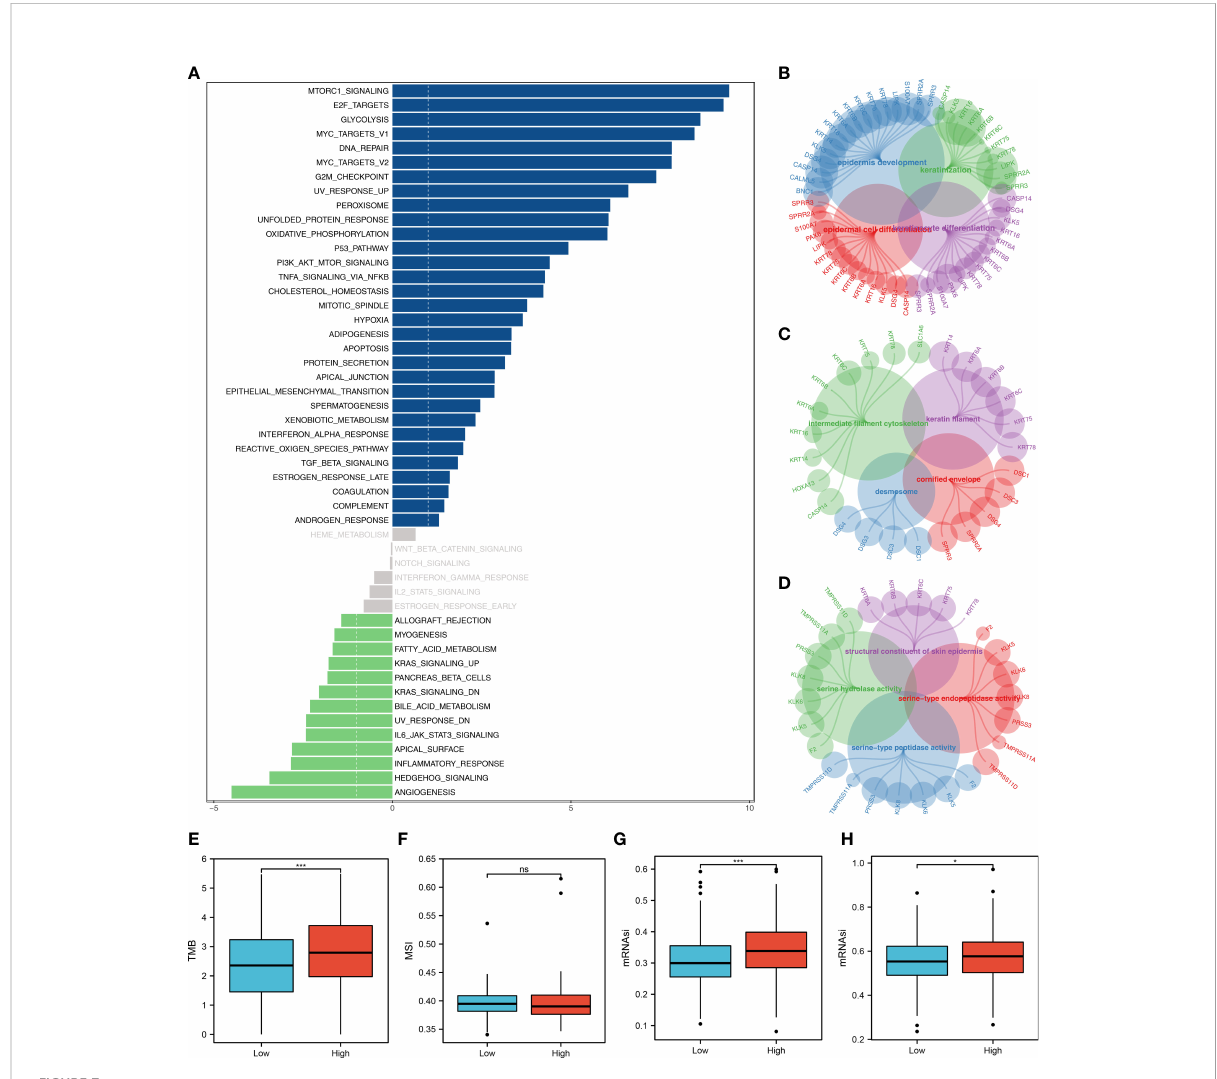
FIGURE 7 Biological enrichment analysis. (A) The GSVA analysis between low- and high-risk groups; (B) The GO-BP enrichment analysis of our model; (C) The GO-CC enrichment analysis of our model; (D) The GO-MF enrichment analysis of our model; (E) The boxplot demonstrated the TMB score in low- and high-risk groups, ***P < 0.001; (F) The boxplot demonstrated the MSI score in low- and high-risk groups, ns P > 0.05; (G) The boxplot demonstrated the mRNAsi score in low- and high-risk groups, ***P < 0.001; (H) The boxplot demonstrated the EGFR-mRNAsi score in low- and high-risk groups, *P <